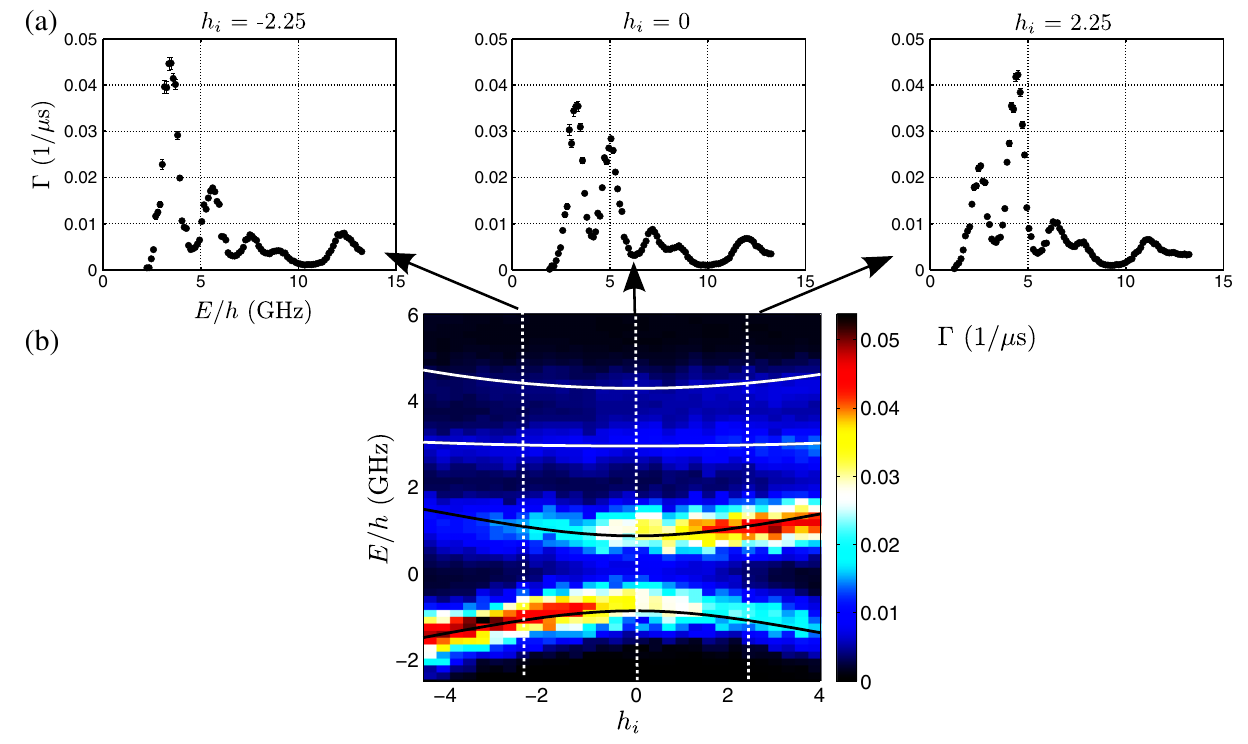
~ J < 0 . (a) Measurements of tunneling rate Γ for three values of FIG. 8. Spectroscopy data for two FM-coupled qubits at P h 1 ¼ h 2 ≡ h . These data were taken at s ¼ 0 . 339 . Peaks in Γ reveal the energy eigenstates of the two-qubit system. (b) Multiple scans i of Γ for different values of h assembled into a two-dimensional color plot. For better interpretability, we have subtracted off a baseline i energy with respect to (a) such that the ground and first excited levels are symmetric about zero. Note the avoided crossing at h 2 [33]. The solid black and white curves plot the theoretical expectations for the energy eigenvalues ψ L peak tunneling rate Γ ∼ j Δ 0 j n ij P h using independent measurements shown in Fig. 6 and Hamiltonian